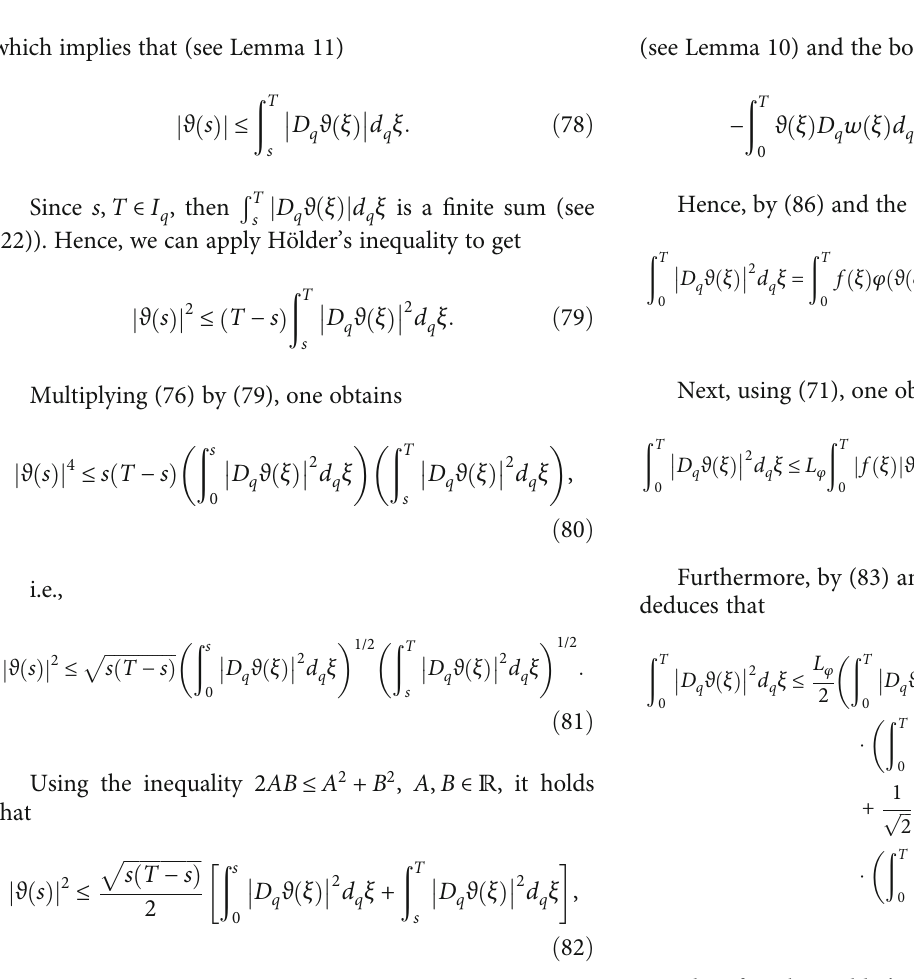
ffiffiffiffiffiffiffiffiffiffiffiffiffiffiffiffi